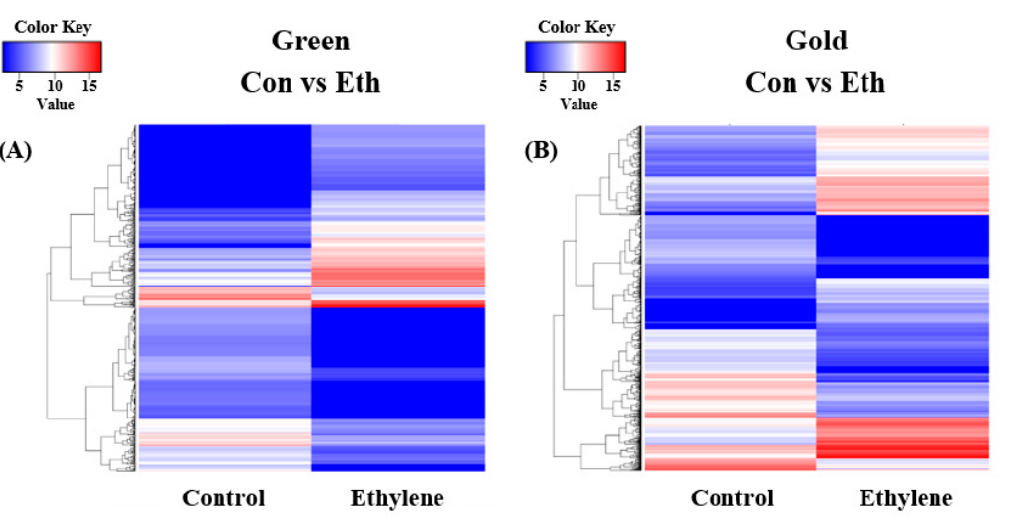
Figure 2. The transcriptional profiles of control vs. ethylene in green ‘Hayward’ and gold ‘Haegeum’ kiwifruit. ( A , B ) Heat map visualization. Each gene is represented by a single row. Red indicates relatively high levels, genes with relatively low levels are shown in blue. ( C , D ) Volcano plot of the identified genes. The DEGs are shown in red and blue, black indicates genes that were not differen- tially expressed. ( E , F ) MA plot of the identified genes. The DEGs are shown in gray ( p > 0.05) and blue ( p < 0.05).